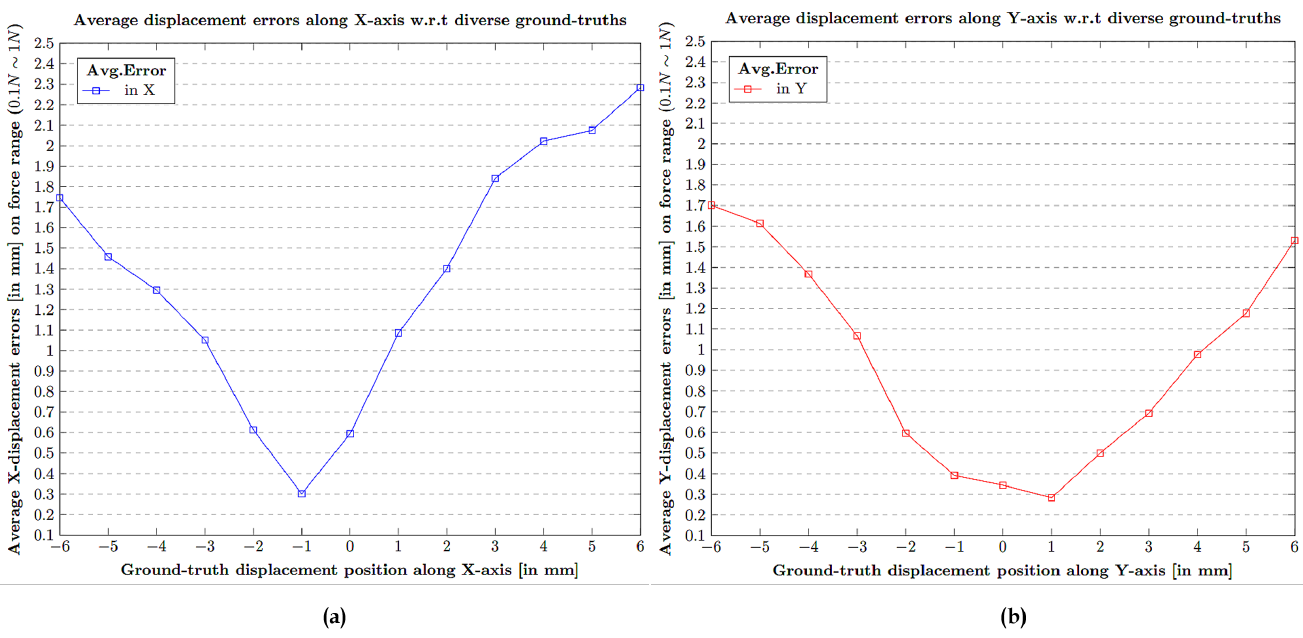
Figure 17. Average displacement error in X , Y contact position w.r.t corresponding ground-truth over 13 points ( − 6 mm ∼ +6 mm): ( a ) Average X-displacement errors (in mm). ( b ) Average Y-displacement errors (in